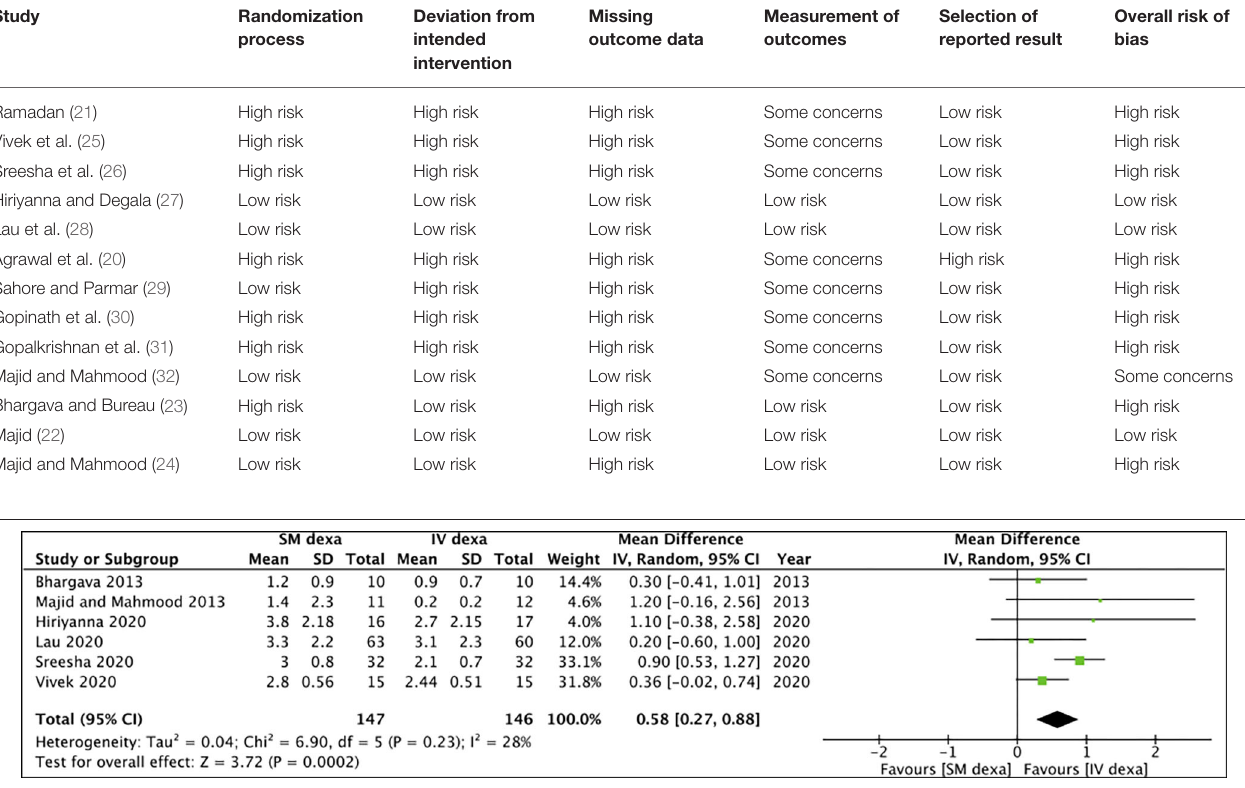
FIGURE 2 | Meta-analysis of early pain between SM and IV dexamethasone (dexa) for third molar surgeries.